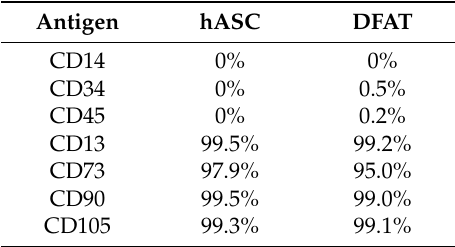
Table 1. Phenotypic analysis by flow-cytometry of human adipose stem cells (hASC) and dedifferentiated mature adipocyte (DFAT). Percentage data of the expression of cell-surface antigens in hASC and dedifferentiated adipocytes at passage 0. CD13, CD73, CD90, and CD105 as a typical panel of mesenchymal stem cells; CD14, CD34, and CD45 as hematopoietic antigens. Data are representative of 12 subjects. Antigen hASC DFAT CD14 0% 0% CD34 0%